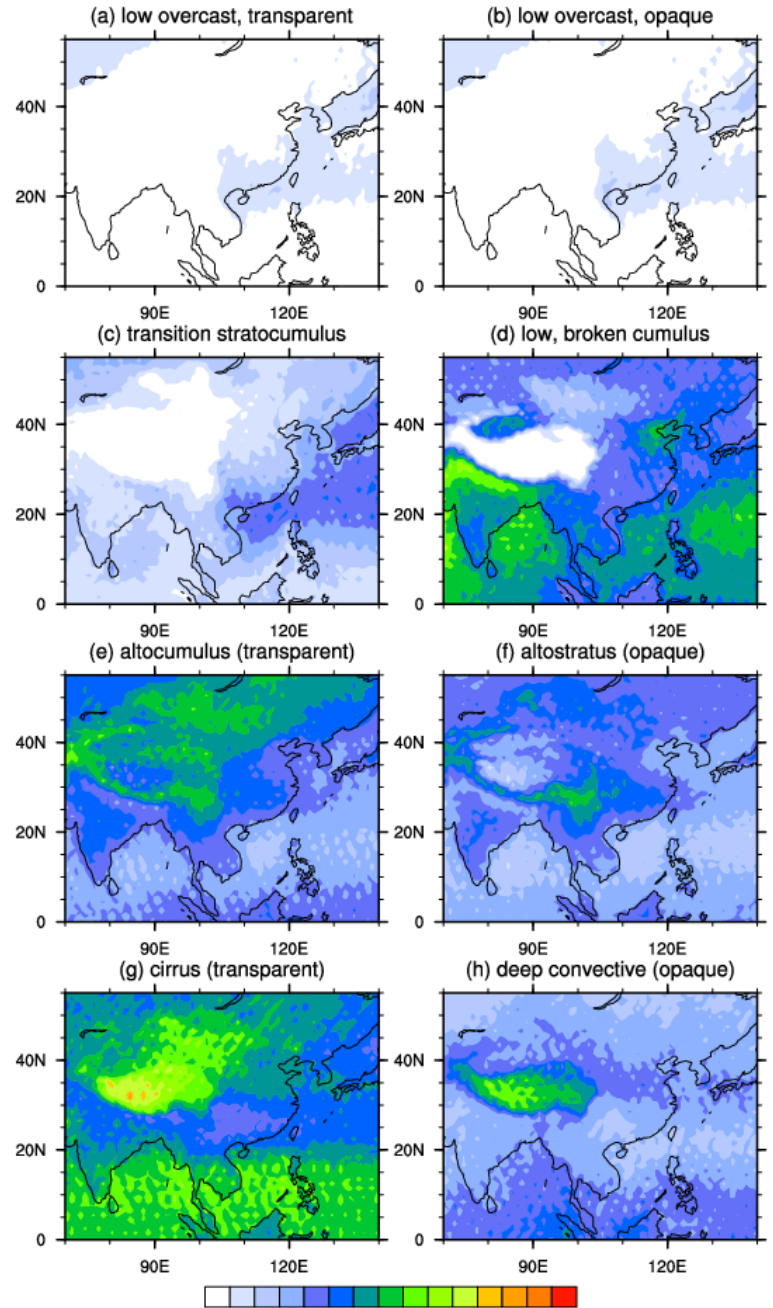
Figure 3. Horizontal distribution of cloud occurrence frequency: ( a ) low overcast (transparent), ( b ) low overcast (opaque), ( c ) stratocumulus, ( d ) low broken cumulus (transparent), ( e ) altocumulus (transparent), ( f ) altostratus (opaque), ( g ) cirrus and ( h ) deep convective cloud (unit: %).